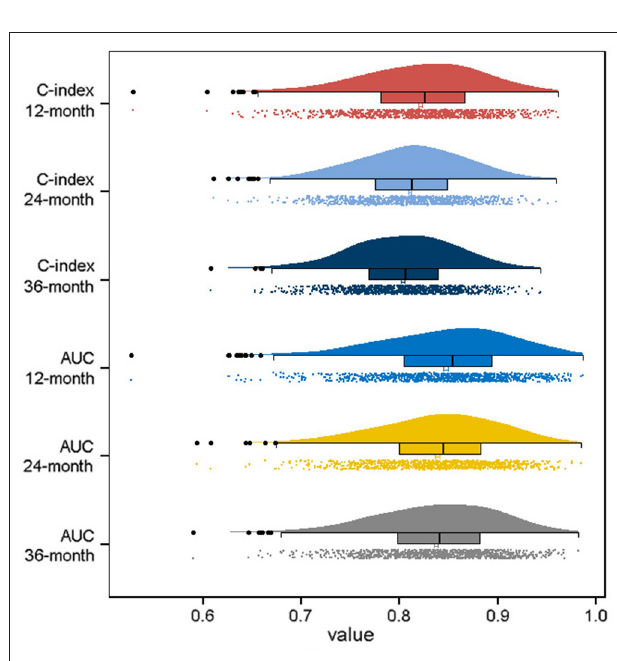
FIGURE 4 | Visualization of the result of k -fold cross-validation ( k = 10) through with half violin plot, scatter plot and boxplot with median.